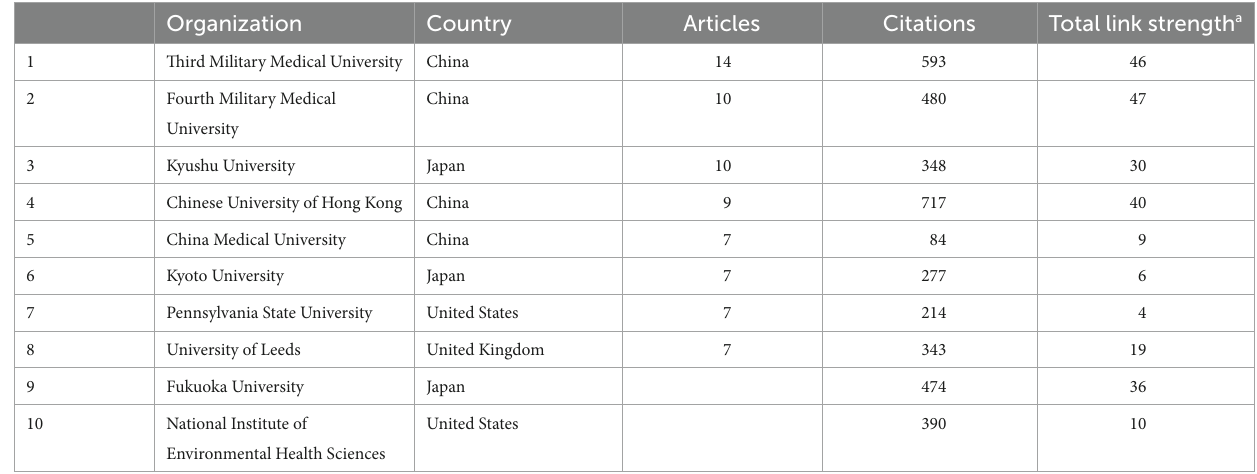
TABLE 1 The 10 most productive